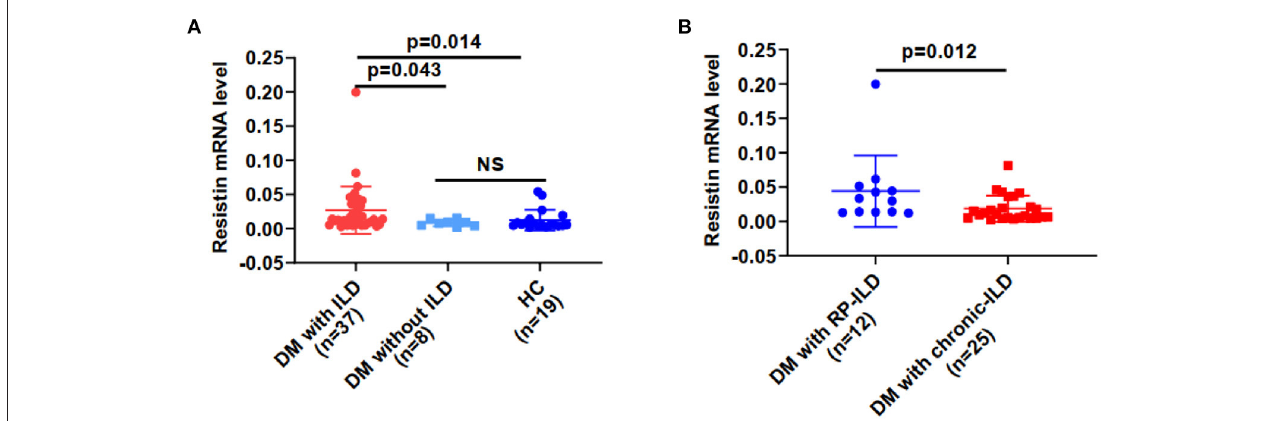
FIGURE 1 | Resistin mRNA levels were higher from PBMCs in DM patients with ILD than in HCs. (A) Resistin mRNA levels in DM patients with ILD, without ILD, and in HCs. (B) Resistin mRNA levels in patients with DM and RP-ILD or chronic ILD. DM, dermatomyositis; HC, healthy control; ILD, interstitial lung disease; RP-ILD, rapidly progressive interstitial lung disease. The relative resistin expression levels in each group were determined via the 2 − 1 Ct method. The data shown are expressed as the mean ±